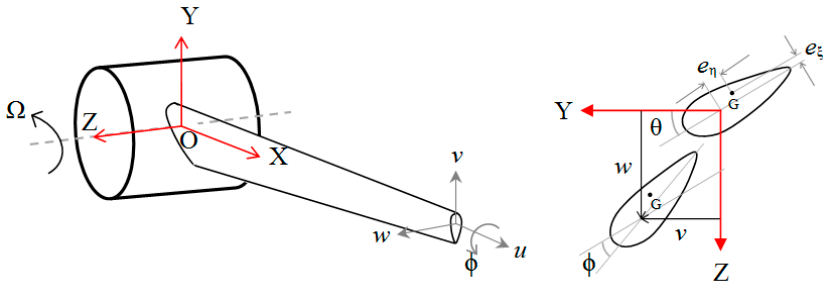
Figure 2. Schematic diagram of the wind turbine blade with vibrations degrees of freedom (DOF).